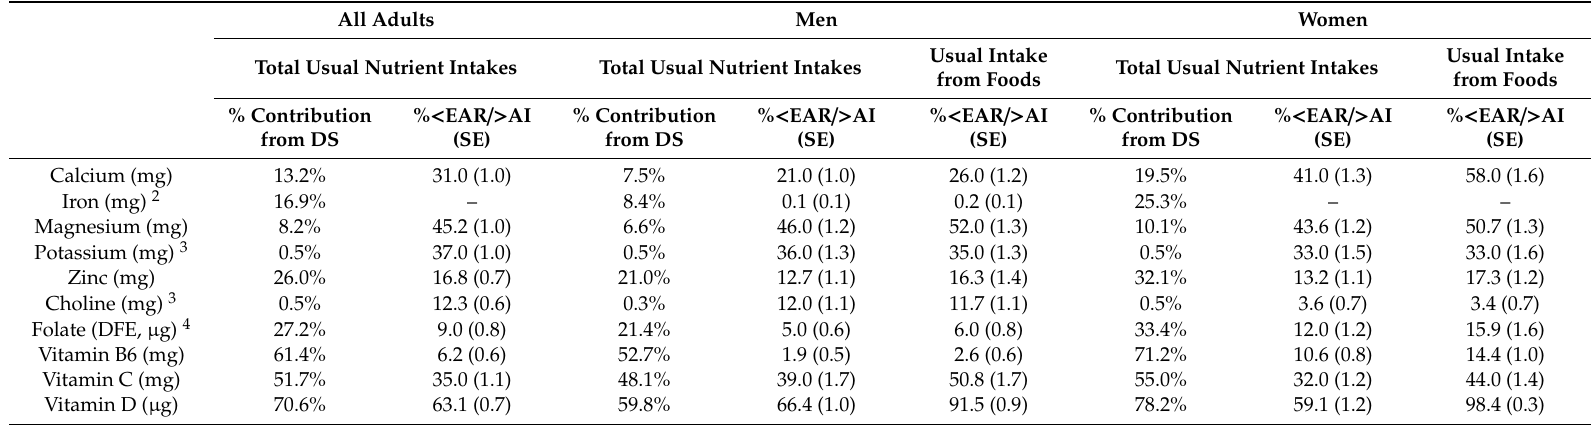
Table 1. Relative contribution of dietary supplements to total usual nutrient intakes and the estimated percent (%) of usual intakes (foods alone and total) below the Estimated Average Requirement or above the Adequate Intake for select nutrients among adults ( ≥ 19 years) in the U.S., 2011–2014.